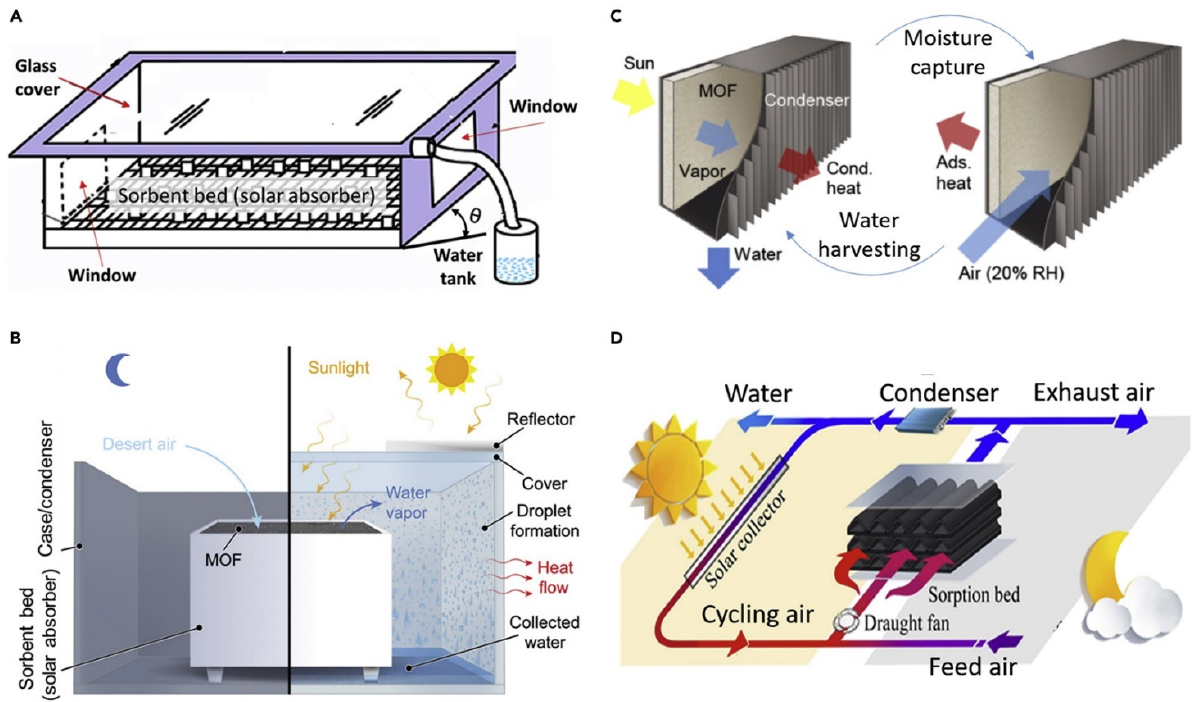
Figure 8. Schematic of fresh water from the humid atmosphere unit. ( A , B ) Glass-covered greenhouse ab- sorber; ( C ) sandwich plate absorber; ( D ) packed column absorber (adapted with permission from Reference [51], Copyright 2018,